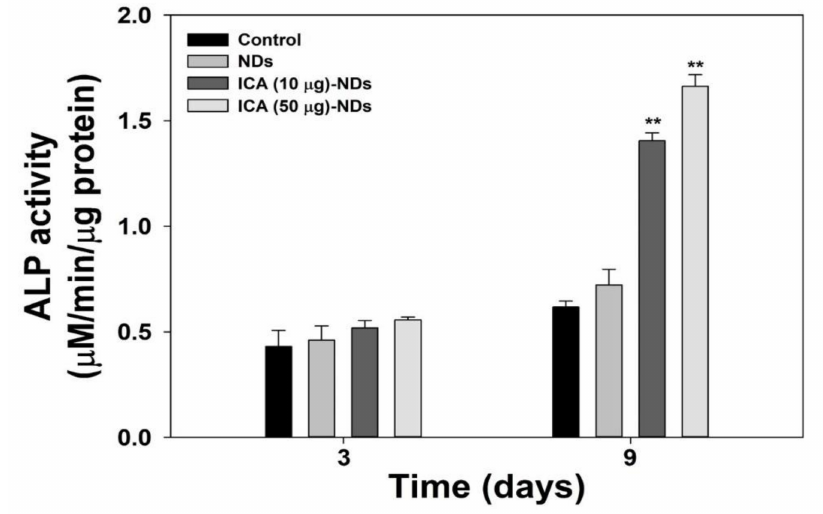
Figure 6. ALP levels of MC3T3-E1 cells cultivated with NDs, ICA (10 µ g)-NDs, and ICA (50 µ g)-NDs after 3 and 9 days of culture ( n = 4 / group). ** p <